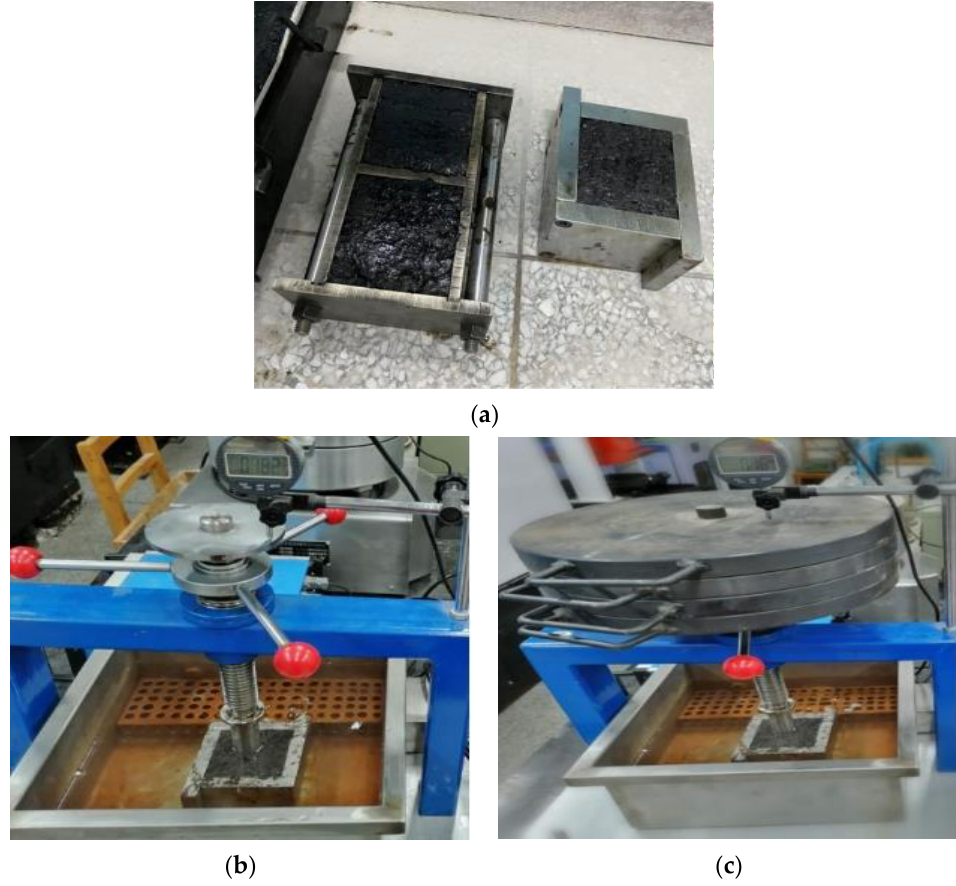
Figure 6. Penetration and penetration increment test of GA-10. ( a ) GA-10 Penetration specimen, ( b ) Initial pressure of penetration specimen, ( c ) Final pressure of penetration specimen.